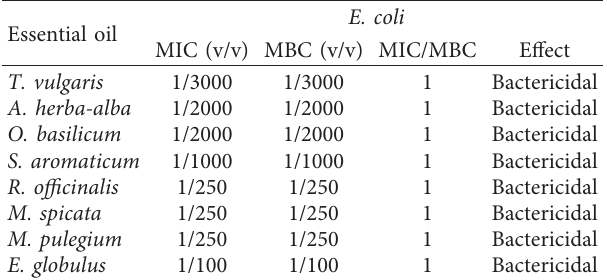
Table 6: Minimum inhibitory concentration (MIC), minimum bactericidal concentration (MBC), and the MIC/MBC